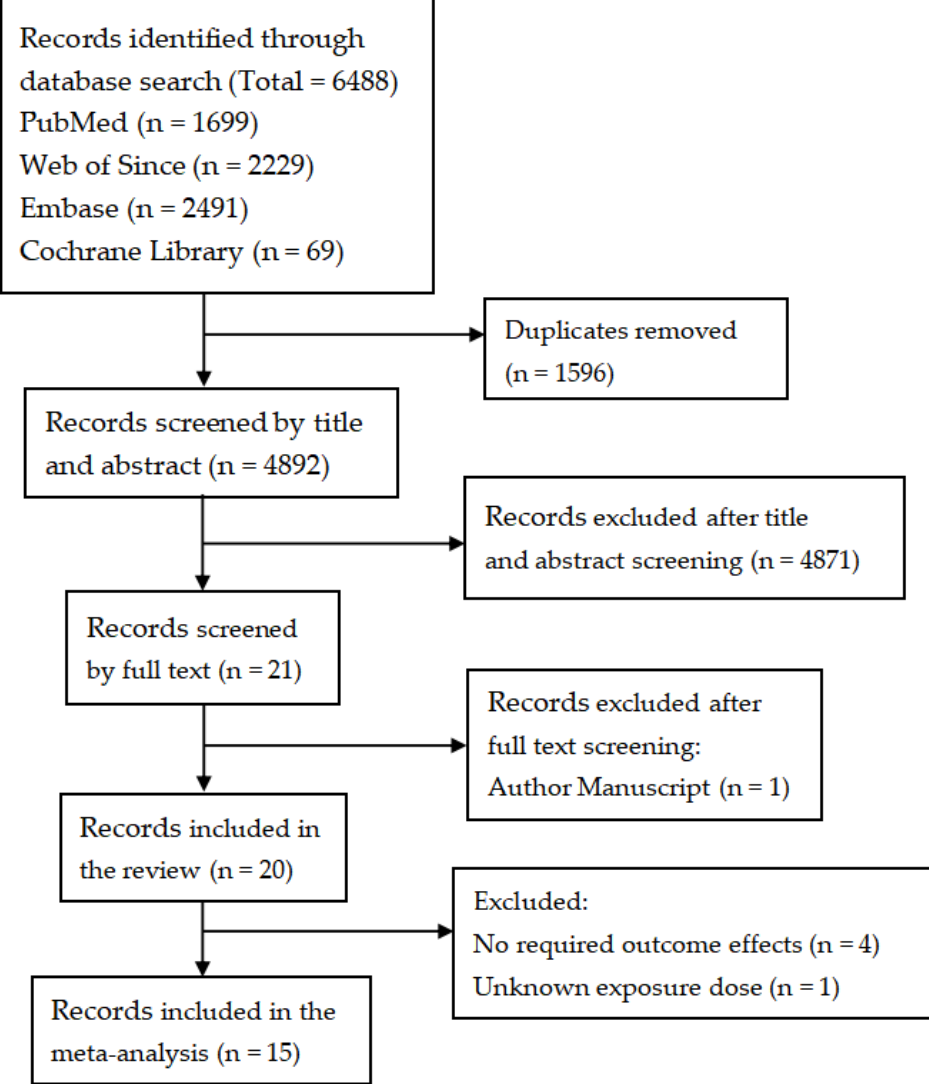
Figure 1. Flowchart of study selection.